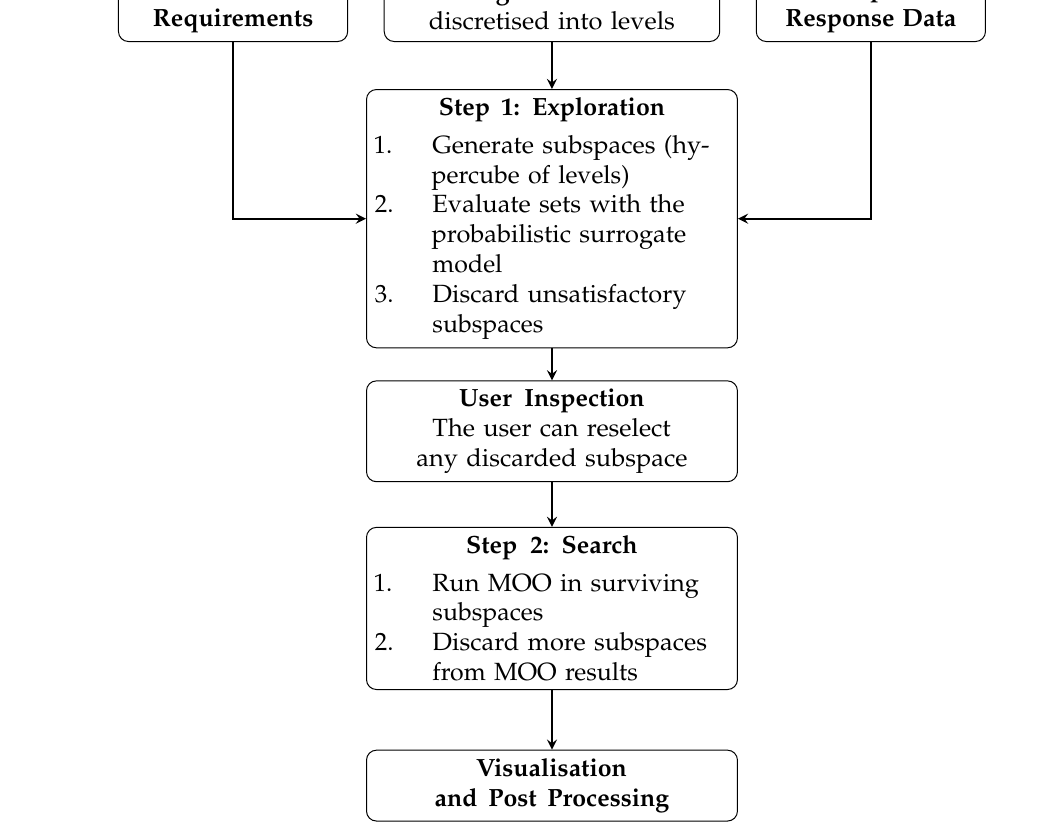
(0–0.25)] (level 0 of both parameters) or [(0.5–0.75), (0.25–0.5)] (level 1 and level 2). Table 1